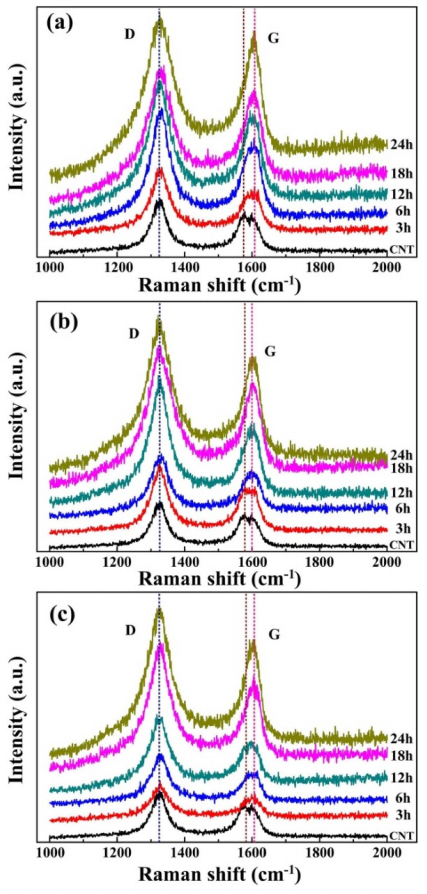
Figure 7. Raman spectra of initial CNTs and the composite powder varied according to milling time: ( a ) CNT and CNT ball milled with 20 µ m Al; ( b ) CNT and CNT ball milled with 9 µ m Al; ( c ) CNT and CNT ball milled with 5 µ m Al.